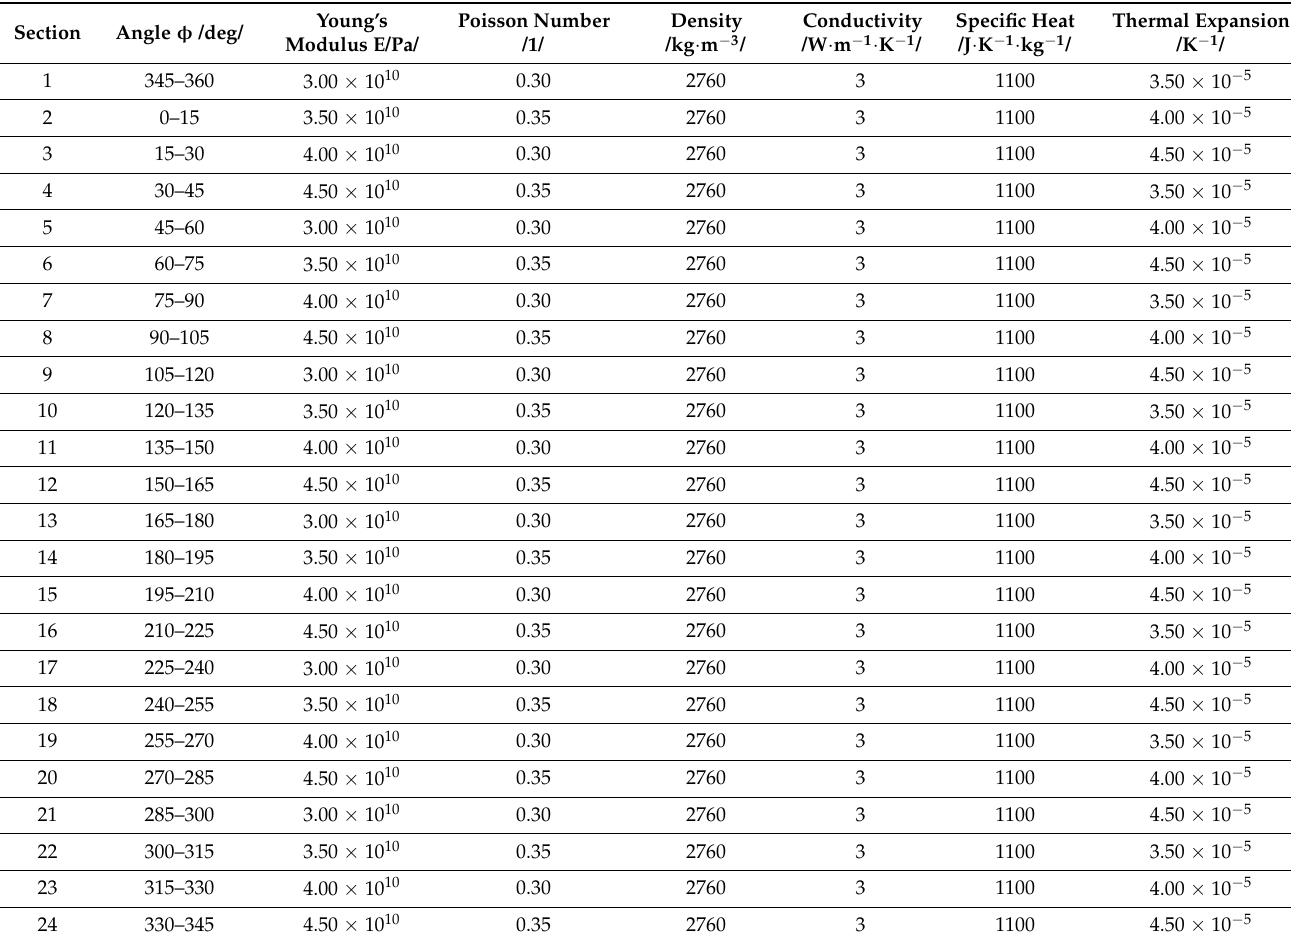
Table 1. Material properties of individual sections of the planar crustal model of the Earth’s